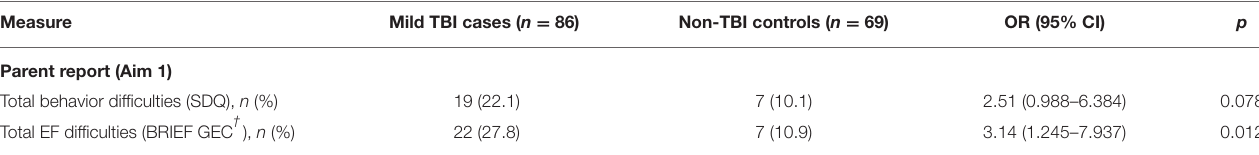
TABLE 5 | The number (and percentage) of children meeting cut-offs for clinically significant * problems in child total outcome scores differentiating mild TBI cases and non-TBI controls.